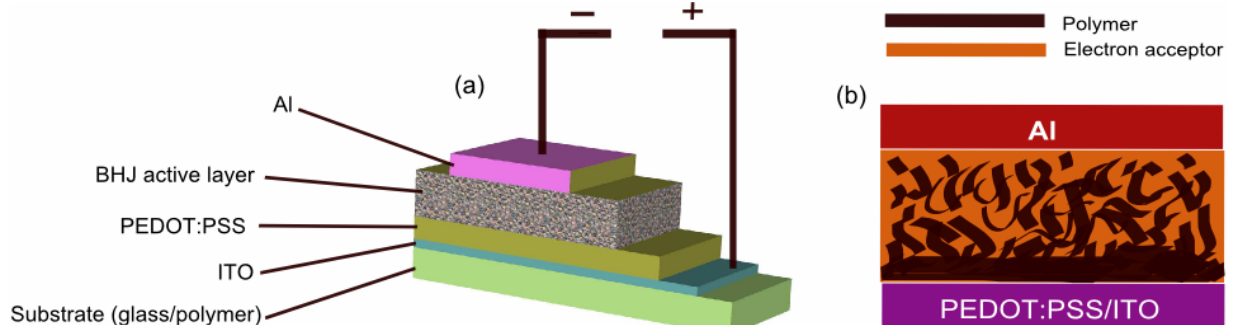
Figure 1. ( a ) Typical bulk-heterojunction (BHJ) device structure; and ( b ) illustration of BHJ active